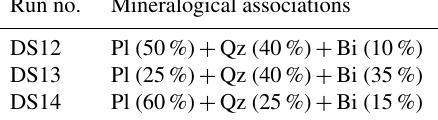
Table 1. Mineralogical assemblage of three natural gneiss samples. Pl: plagioclase, Qz: quartz and Bi: biotite. Run